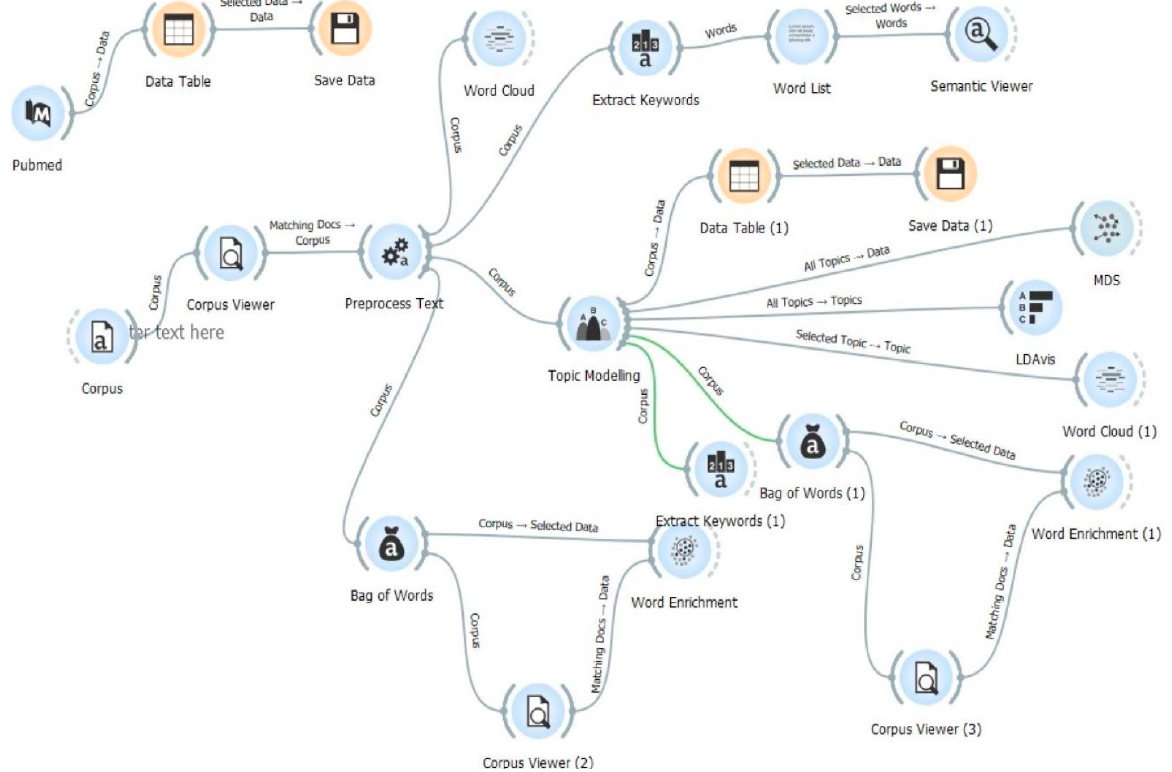
Figure 1. The workflow used for text mining analysis.